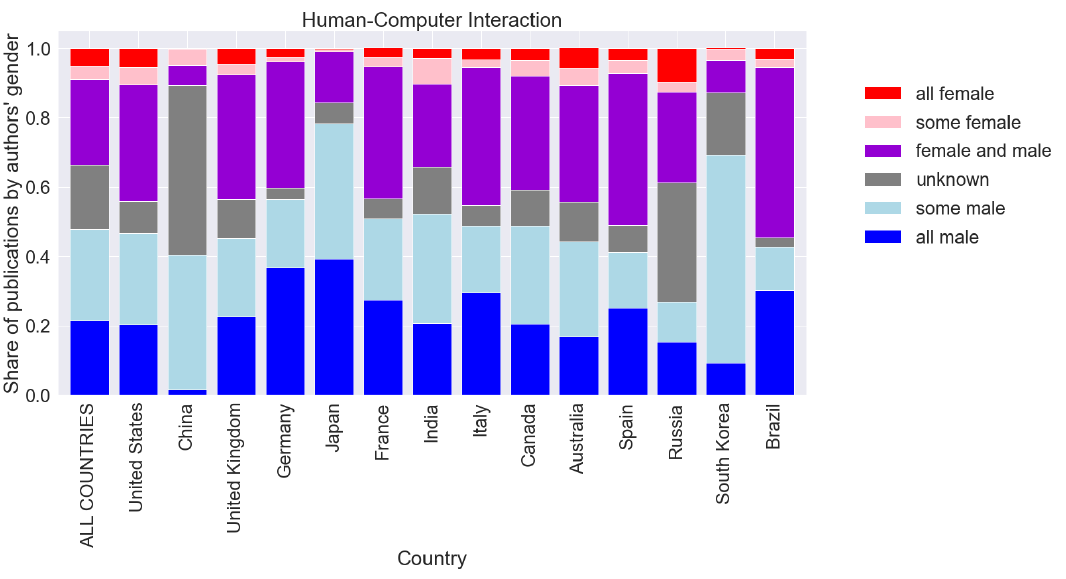
Figure 1. Shares of the six author gender classes within publications in the human-computer interac- tion document set. The column ALL COUNTRIES gives the fractions among all publications, while the other columns give a breakdown according to countries. The grey-coloured segments indicate publications where the gender of none of the authors could be derived from the name. The publica- tions of the pink and light blue segments have at least one female or male author, respectively, but there are co-authors of unidentified